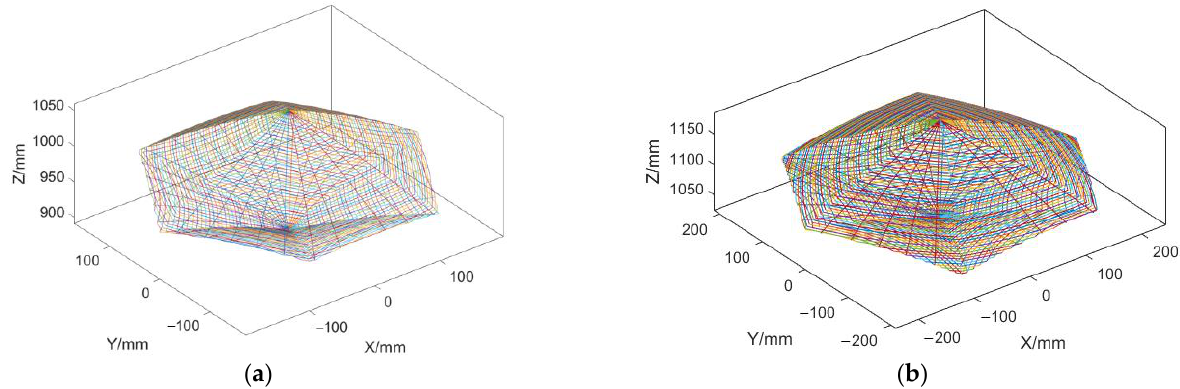
Figure 17. Three-dimensional distribution of the workspace: ( a ) Before optimization; ( b ) After op-